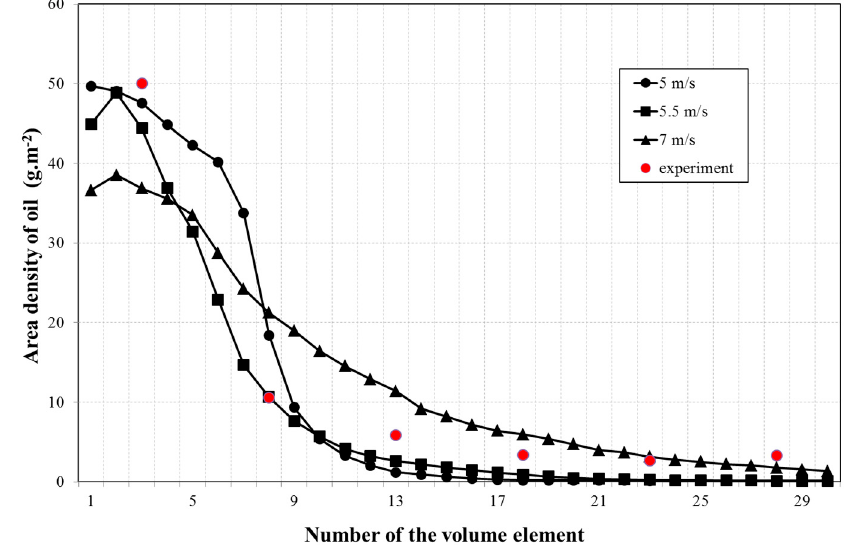
Figure 5. Plot of the areal density of oil at three different velocities on an inner pipe with a diameter of 25 mm pipe.